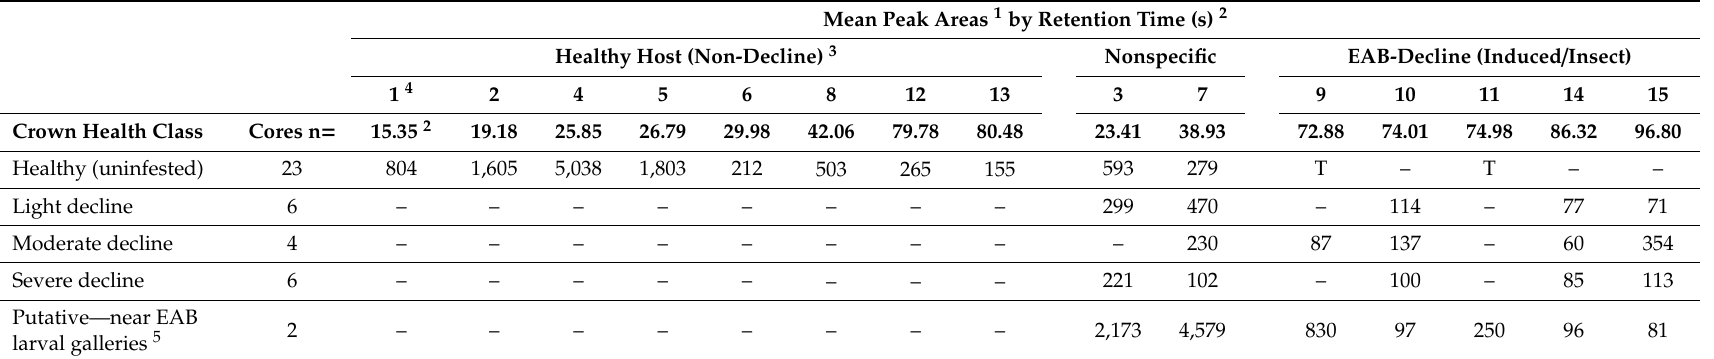
Table 4. Aroma class-specific production of VOC-metabolites by healthy host and EAB-decline associated response within green ash